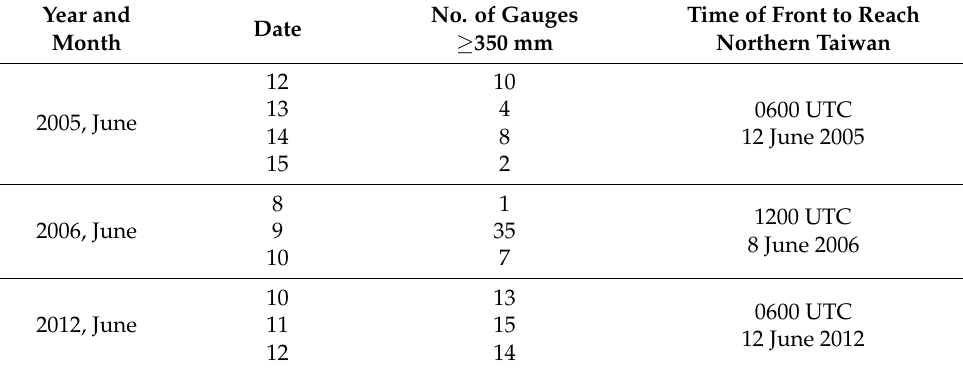
Table 1. Mei-yu heavy rainfall events (in May–June) that reached a peak daily rainfall amount of ≥ 350 mm for at least three days in a row during